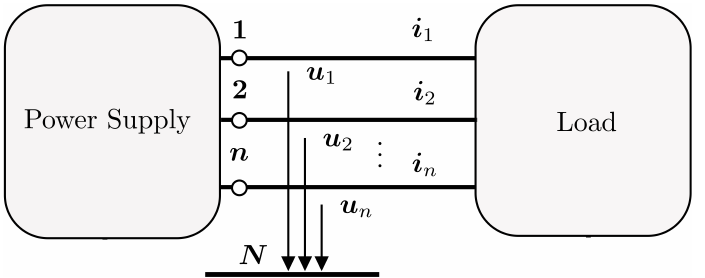
Figure 1. Representation of an n -phase, ( n + 1)-wire circuit with virtual star point N . Line to virtual neutral point voltages and line currents are